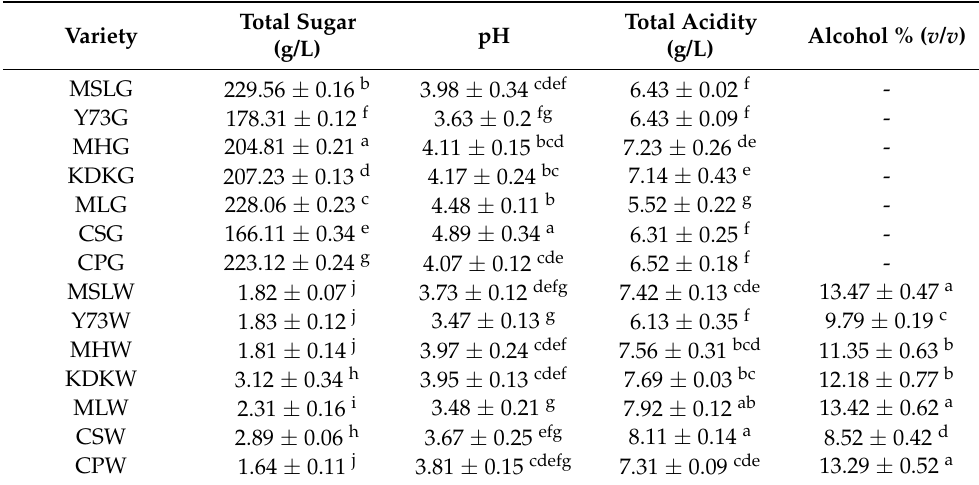
Table 1. Classic physicochemical indexes of different grape and wine